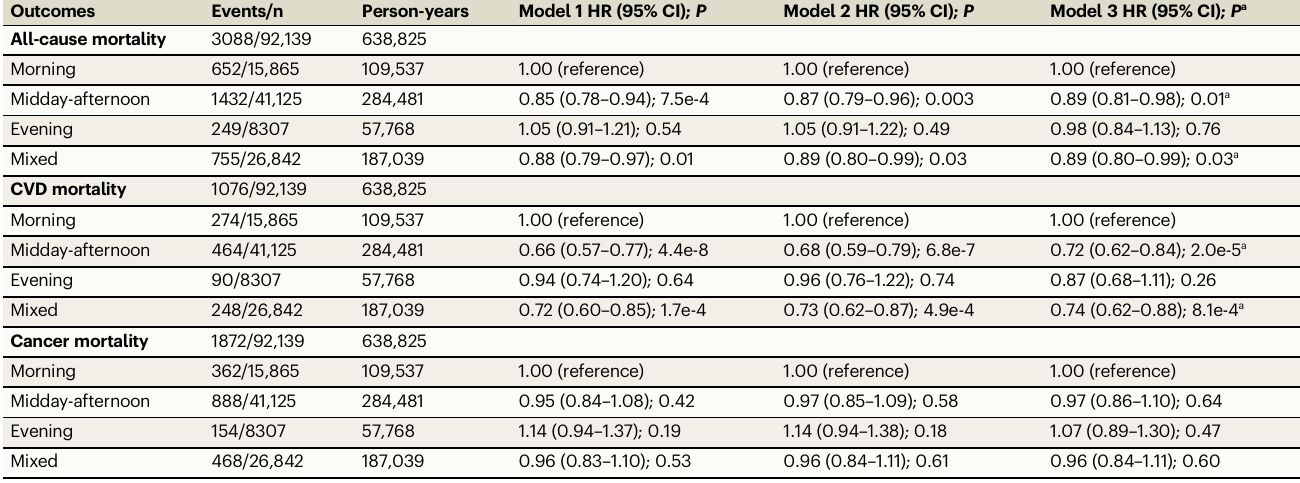
Table 2 | The associations between the timing of MVPA and mortality risk Outcomes